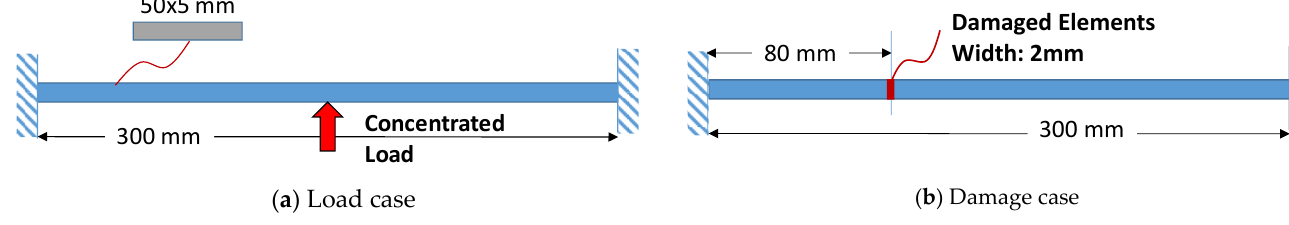
Figure 2. The target beam-like structure under loading and damage cases (unit: mm).